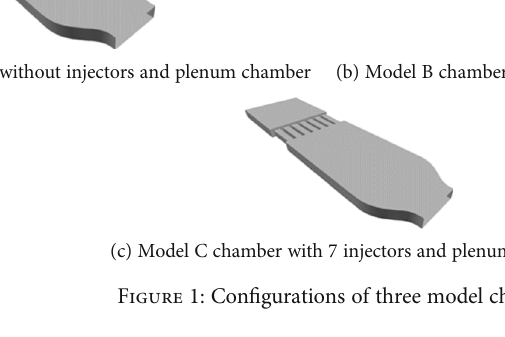
and 180 mm, respectively. The transverse sizes of the model chamber and nozzle throat are 88 mm and 45.2 mm, respec- tively. The thickness (spanwise size) of this slice chamber is 12 mm. The transverse and spanwise ( y direction) sizes of these injectors are 10 mm, while their length is set as 22, 32, 44, 62, 78, and 100 mm for di ff erent cases. The length and width of the plenum chamber are 100 mm and 88 mm, respectively. Compared with transverse size of the injector with 10mm, there is a contraction with 5 mm at the inlet of the injector, which is shown in Figures 1 and 2. So, the injec- tor ’ s outlet is an open end, while its inlet is a half-open end; it is corresponding to that in engineering.